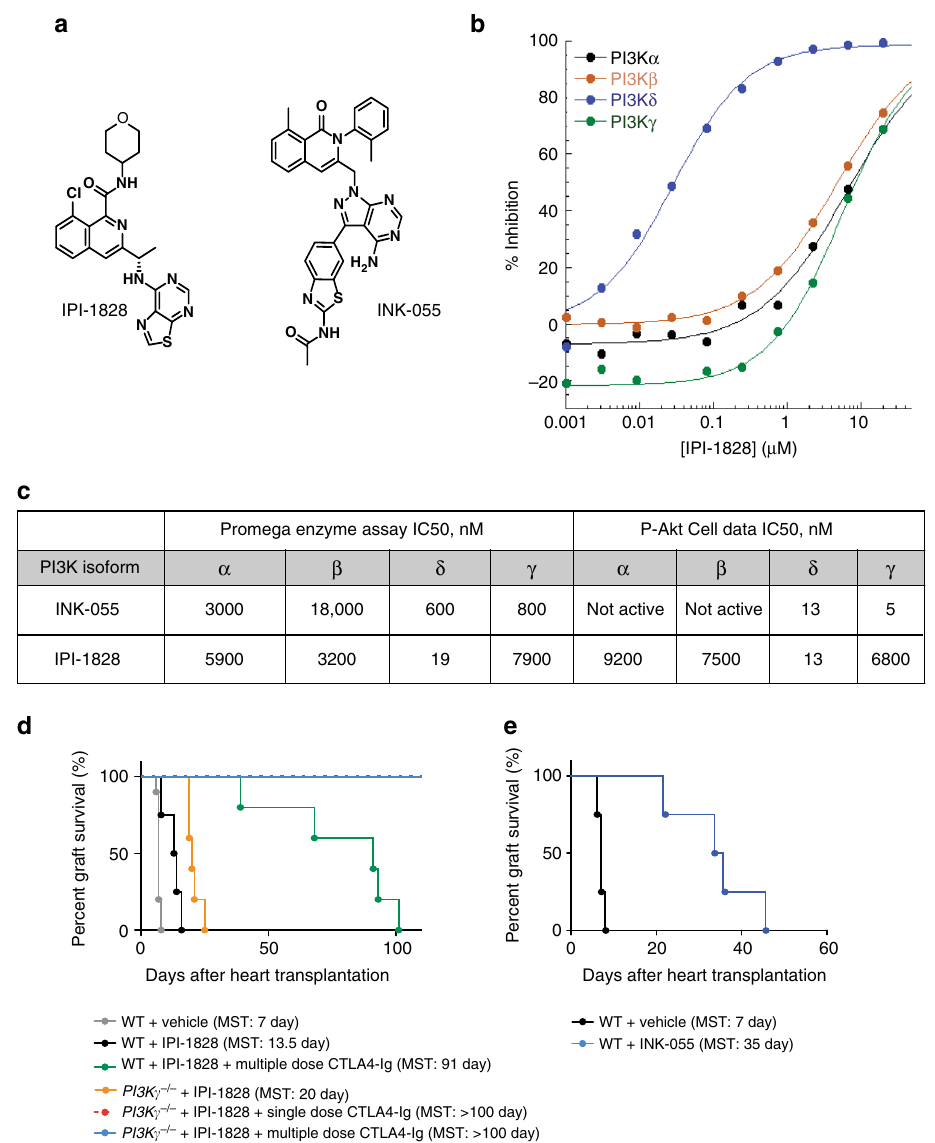
Fig. 6 Synthesis of new PI3K δ and γδ inhibitor. The characterization of IPI-1828, a PI3K δ selective compound, and INK-055, a PI3K γδ inhibitor. a The chemical structure of IPI-1828 and INK-055. b Isotherms of IPI-1828 inhibitory activity in enzymatic assays for Class 1 PI3Ks were determined by monitoring the hydrolysis of ATP with a luminescence-based end point assay as described in methods section. This assay was run in the presence of 3 mM ATP and 500 uM PIP 2 substrates. The ATP concentration of 3 mM was used to more to closely resemble cellular concentrations. c Summary of IC50s in a biochemical assay run in the presence of 3 mM ATP, and isoform selective cell-based assays for class 1 PI3Ks. d Synergism of PI3K δ and PI3K γ inhibition in prolonging allograft survival. Kaplan – Meier survival of heart allografts in WT and PI3K γ − / − recipients treated with PI3K δ inhibitor (IPI-1828) and single dose CTLA4-Ig or multiple dose CTLA4-Ig. ( n = 5/group). e Kaplan – Meier survival of heart allograft in WT recipients treated with PI3K γδ inhibitor (INK-055) showed signi fi cant prolongation of heart allograft survival compared to control (MST of 35 vs. 7 days, * p < 0.05, t -test, n = 5/group). (MST mean survival